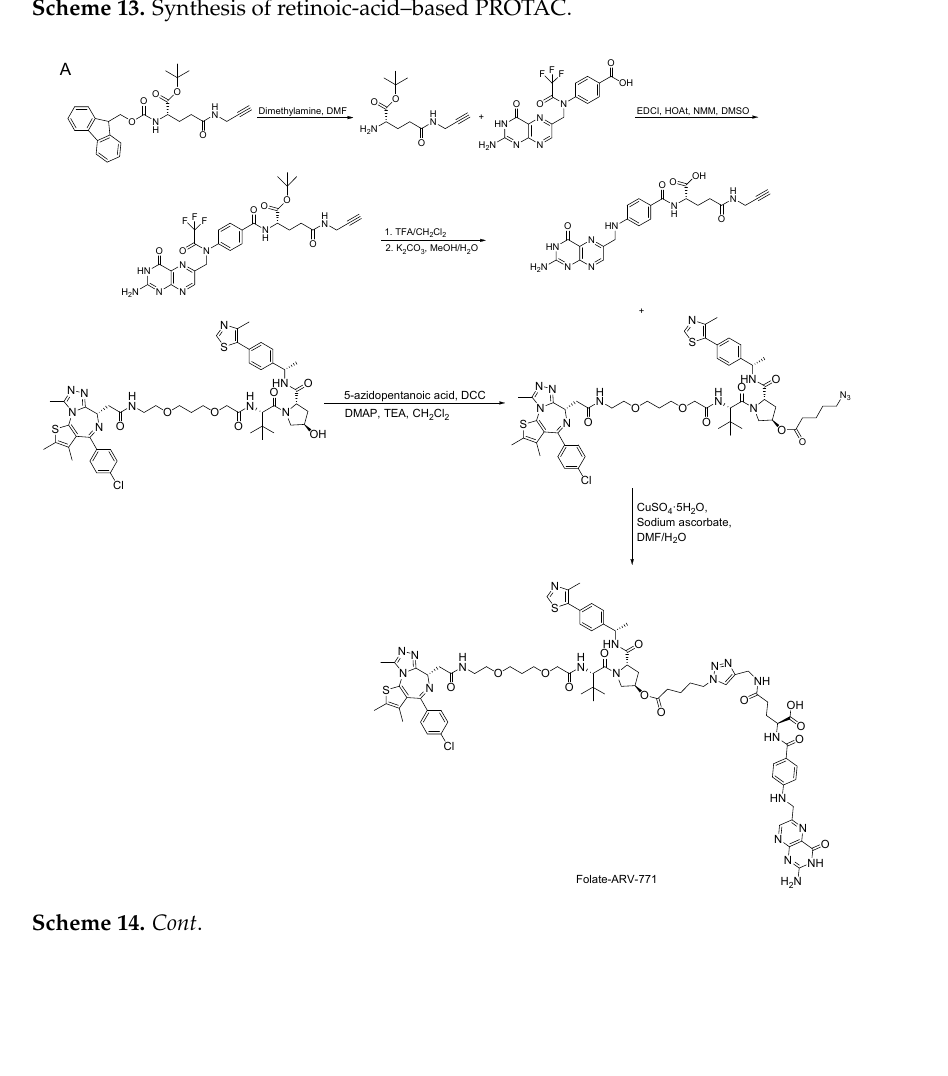
Scheme 13. Synthesis of retinoic-acid–based PROTAC.